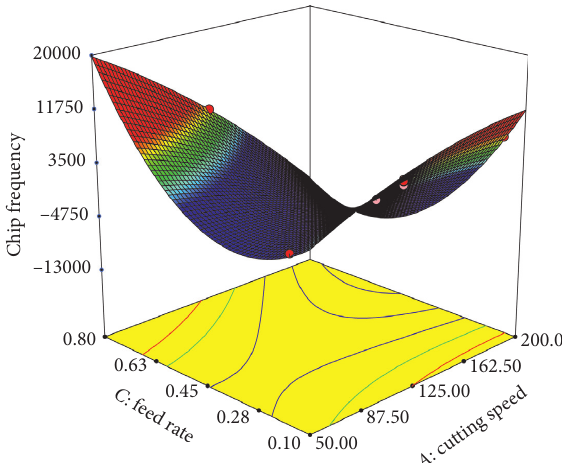
Figure 17: Surface plot of chip frequency based on the combi- nation of depth of cut and feed